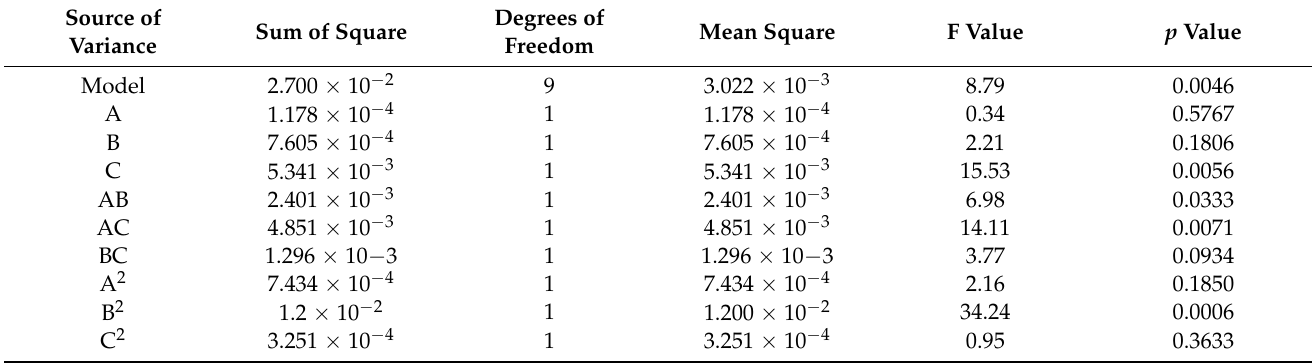
Table 5. Variance analysis of regression